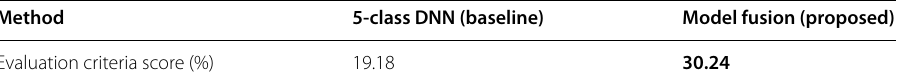
Table 8 The score of evaluation criteria for the proposed and baseline models using external testing